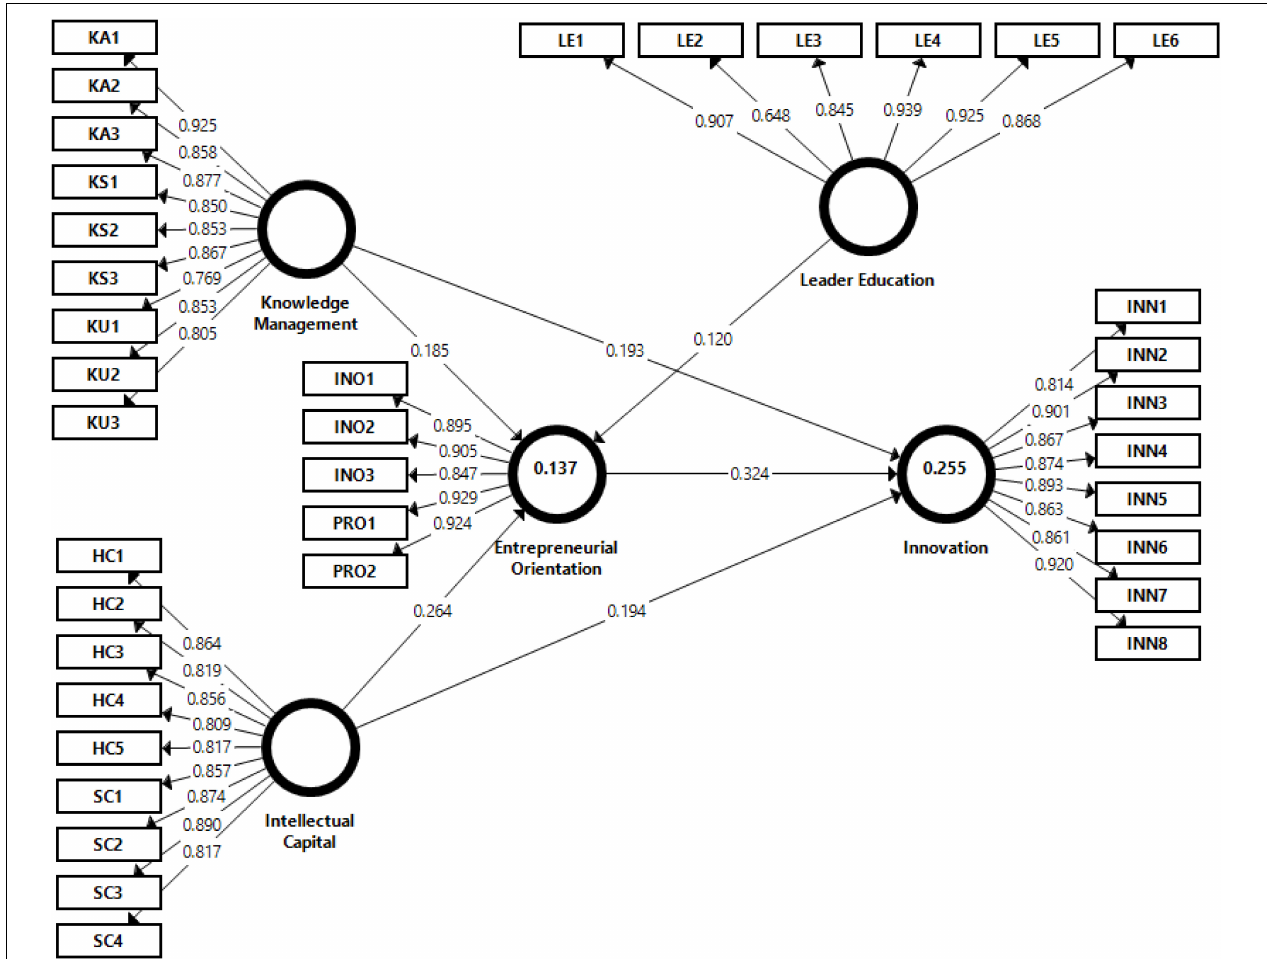
FIGURE 2 | Measurement